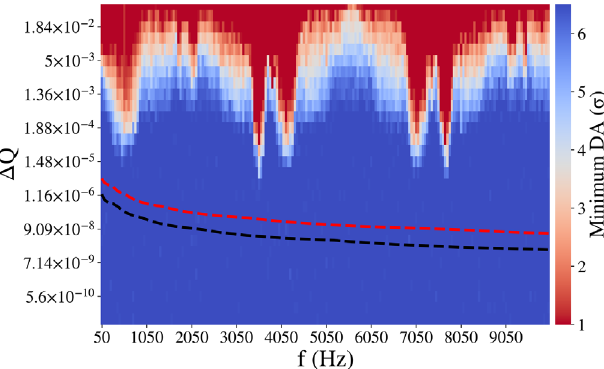
FIG. 6. Critical tune modulation depth Δ Q as a function of modulation frequency f m color-coded with the minimum DA in the presence of power supply ripple in the inner triplet quadru- poles. The simulation parameters are listed in Table II and the tracking is performed in the element-by-element HL-LHC lattice, including beam-beam interactions and chromatic tune modula- tion with Δ Q ¼ 4 × 10 − 3 . The red and black lines represent the sum and the root mean square of the contribution from all the circuits, respectively, computed from the power supply specifi- cations of Table VI and Eq.